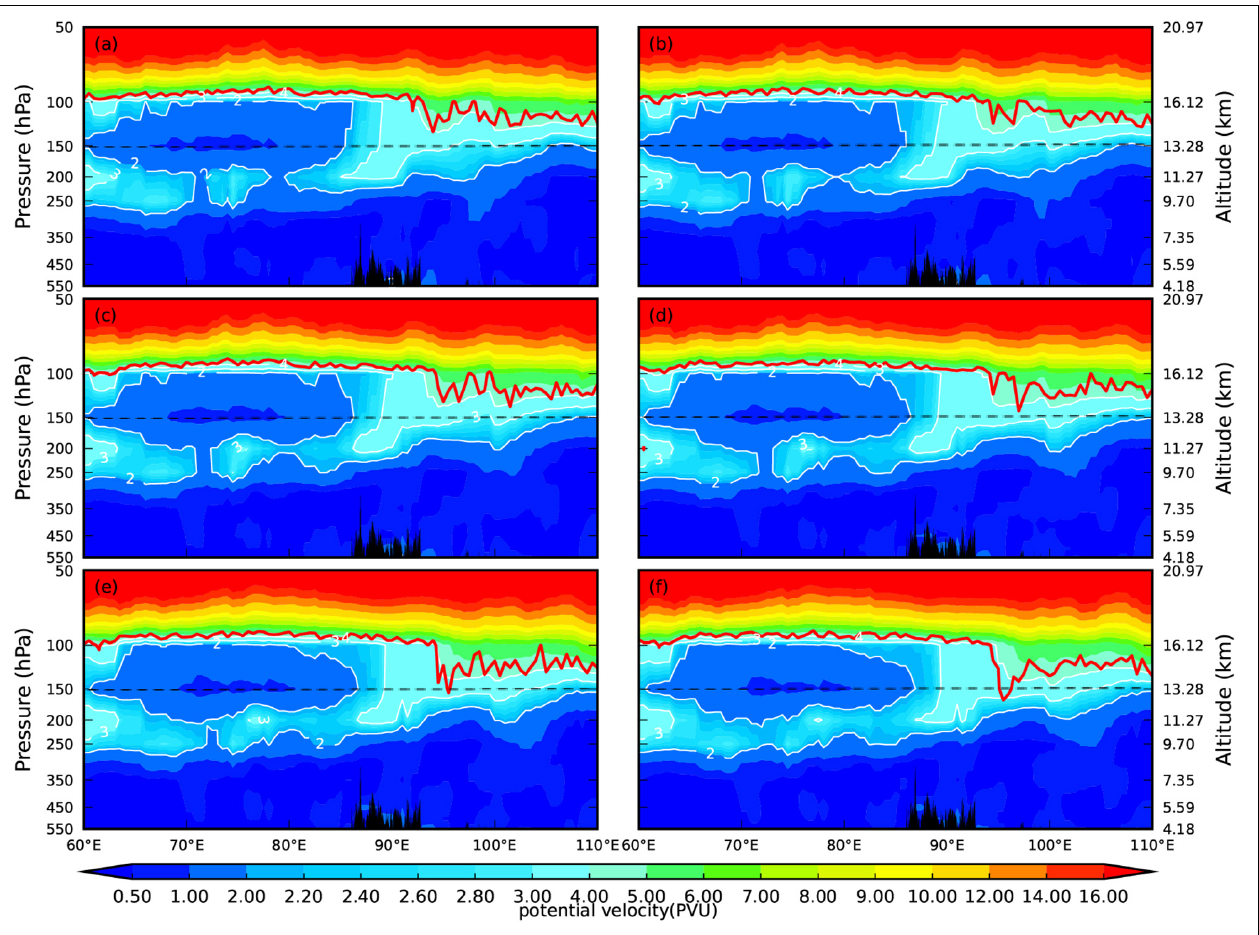
FIGURE 12 | Longitude–height cross section of potential vorticity (unit: PVU) along 28 ◦ N simulated by WRF. The red lines indicate the thermal tropopause. The dashed black lines are 150 hPa. Times shown are (a) 18:20; (b) 19:20; (c) 20:20; (d) 21:20; (e) 22:20; and (f) 23:20.